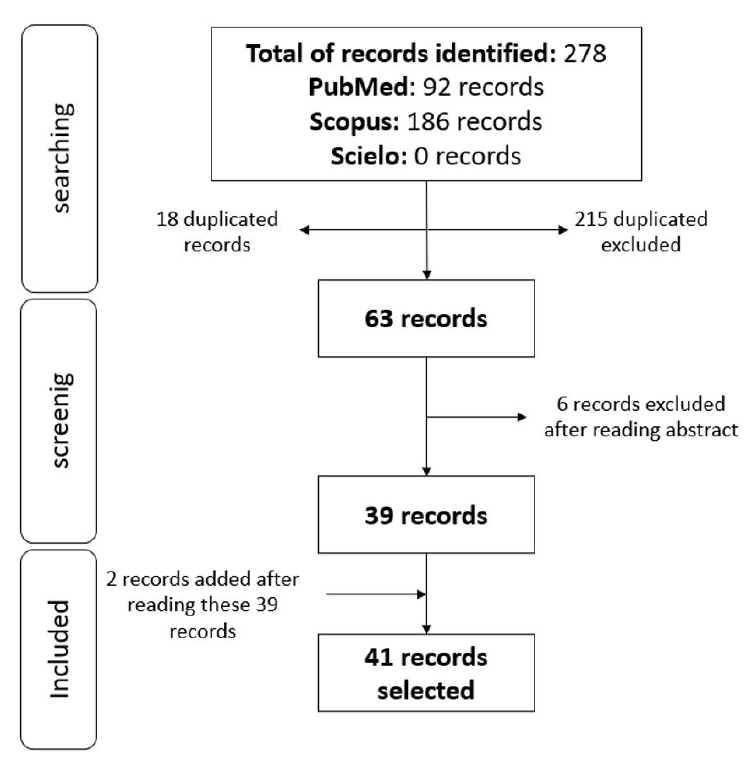
Figure 1. Retrieval flow